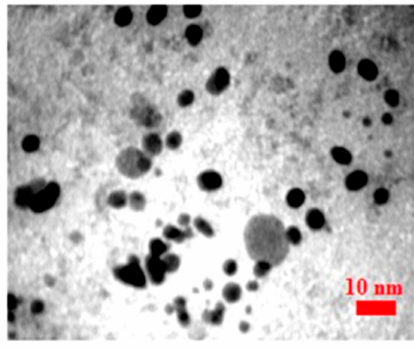
Figure 3. Transmission electron microscopy images and histogram of biosynthesized IONPs.